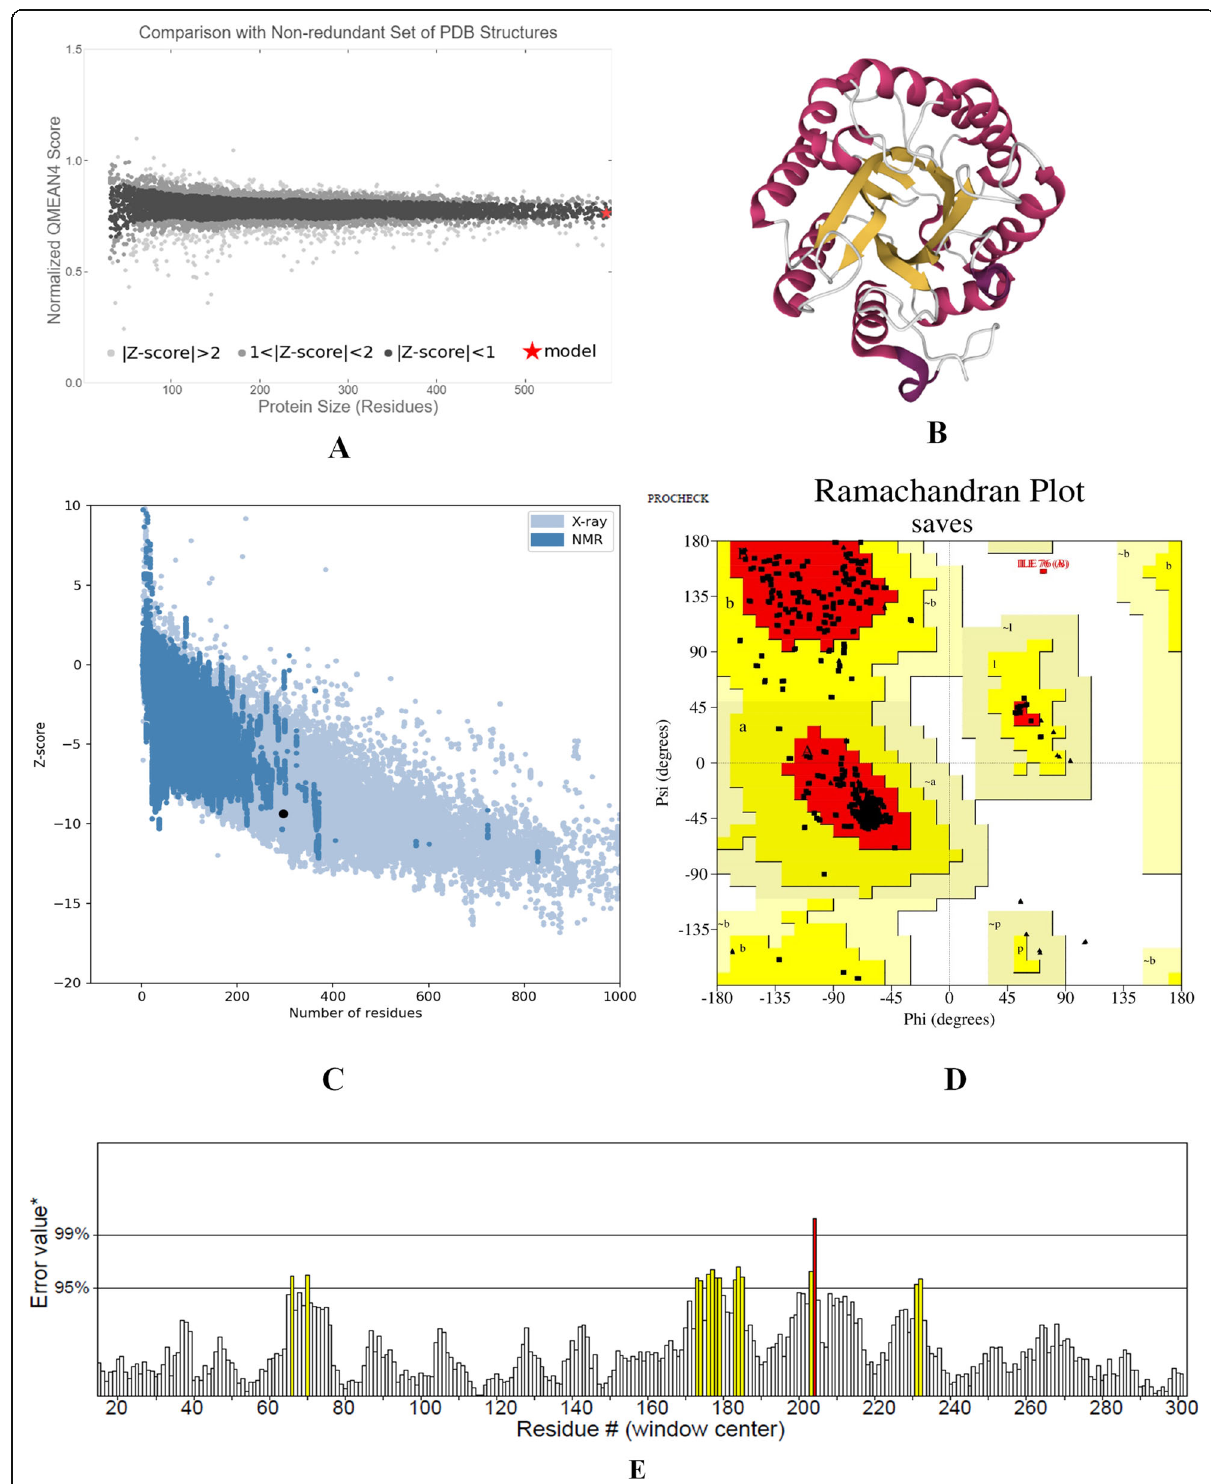
Fig. 6 Visualization of cellulase tertiary structure (PDB ID 5I2U). a QMEAN4 Z score. b cellulase 3D structure. c Z score value generated by ProSA server. d Ramachandran plot showing the distribution of amino acids phi/psi angles. e ERRAT value showing structure